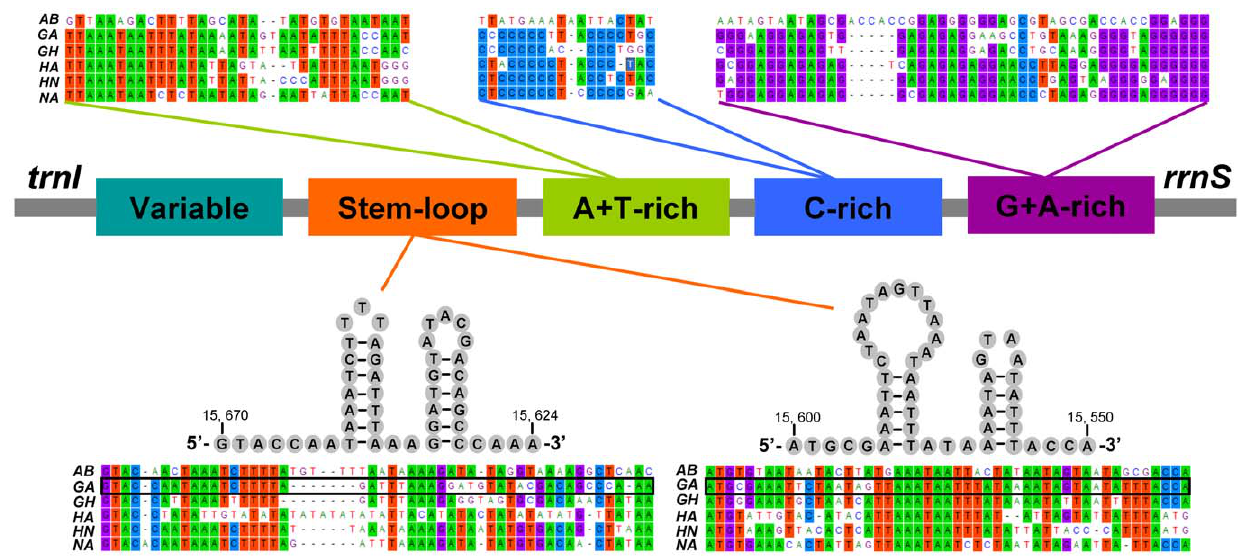
Figure 3. Organization of the control region in six nabid mtDNAs. The colorized panes indicate the structural elements in the CR. The alignment of the primary sequences and the predicated secondary stem-loop structures are shown, respectively, above and below.